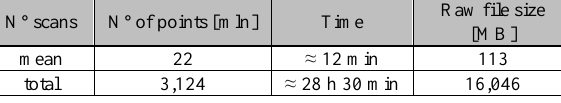
Table 4. TLS scans specifications.